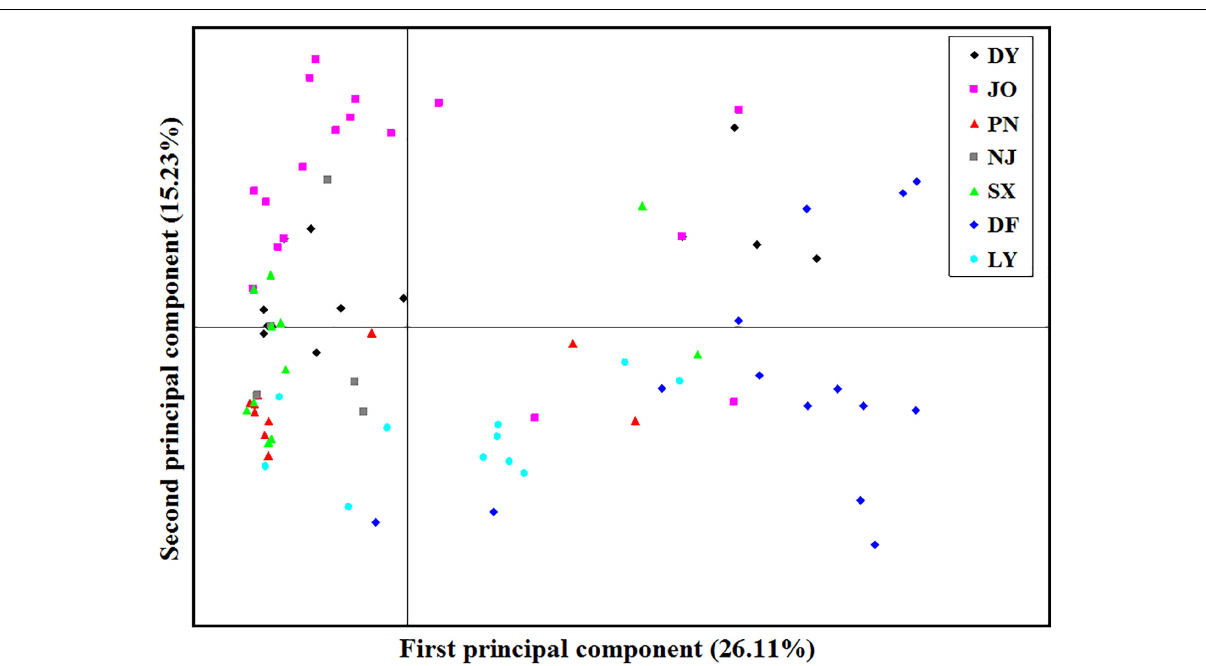
FIGURE 4 | Principal component analysis (PCoA) based on inter-simple sequence repeat marker data for 117 individual isolates collected from seven locations in Fujian Province. Individuals within the same population are marked using the same color and symbol. DY, JO, PN, SX, LY, DF, and NJ represent the S. turcica isolates collected from the Dongyou, Jian’ou, Pingnan, Songxi, Longyan, Dongfeng, and Nanjing regions of Fujian Province, respectively. The first and second principal coordinates account for 26.11 and 15.23% of the variation,